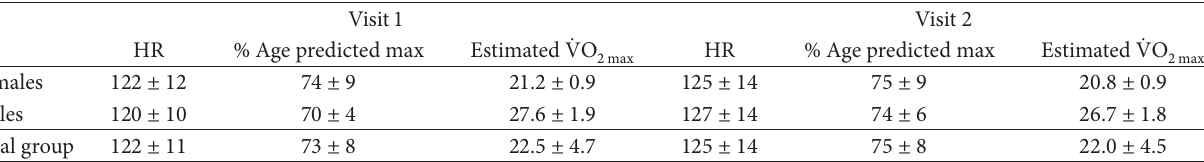
Table 3: Heart rate (bpm and % age predicted maximum) and corresponding estimated performed the Siconolfi step test.